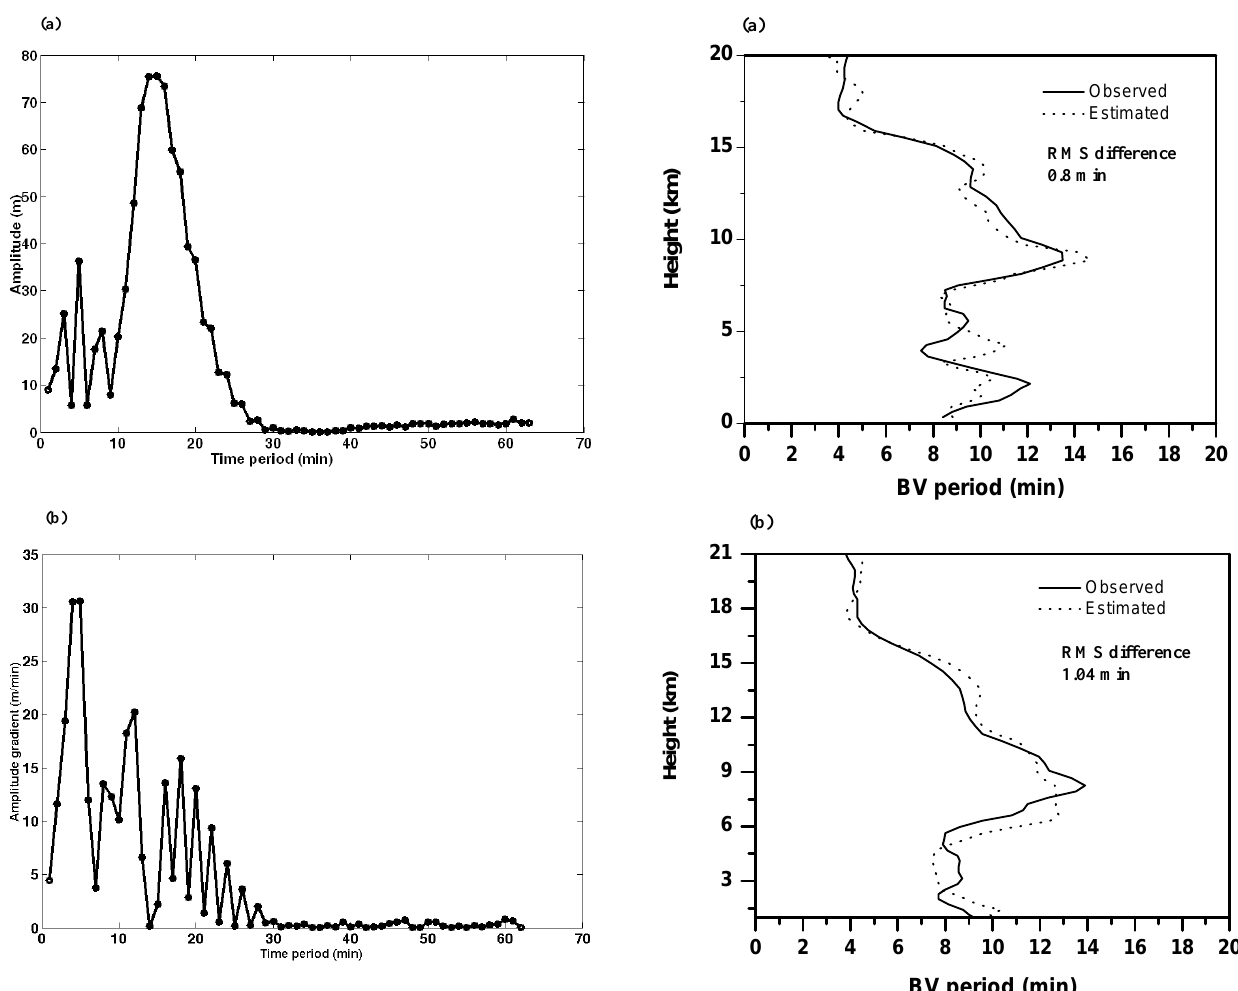
Fig. 4. (a) Amplitude spectra at 18km height region and (b) same as (a) but for amplitude gradient.